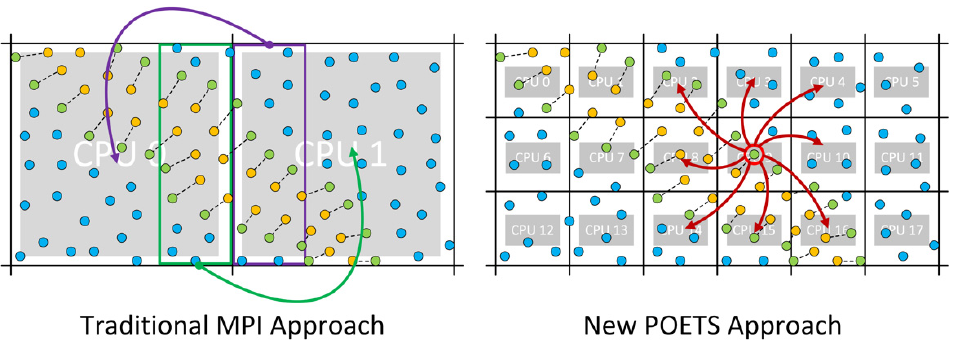
Figure 3. Contrast between the traditional MPI-based parallelization approach (left panel) in which each CPU owns a volume of space containing hundreds or thousands of beads, and the POETS approach (right panel) where space is sub-divided down to unit-volume cells containing only 3 or 4 beads, each of which is managed by one light-weight CPU.